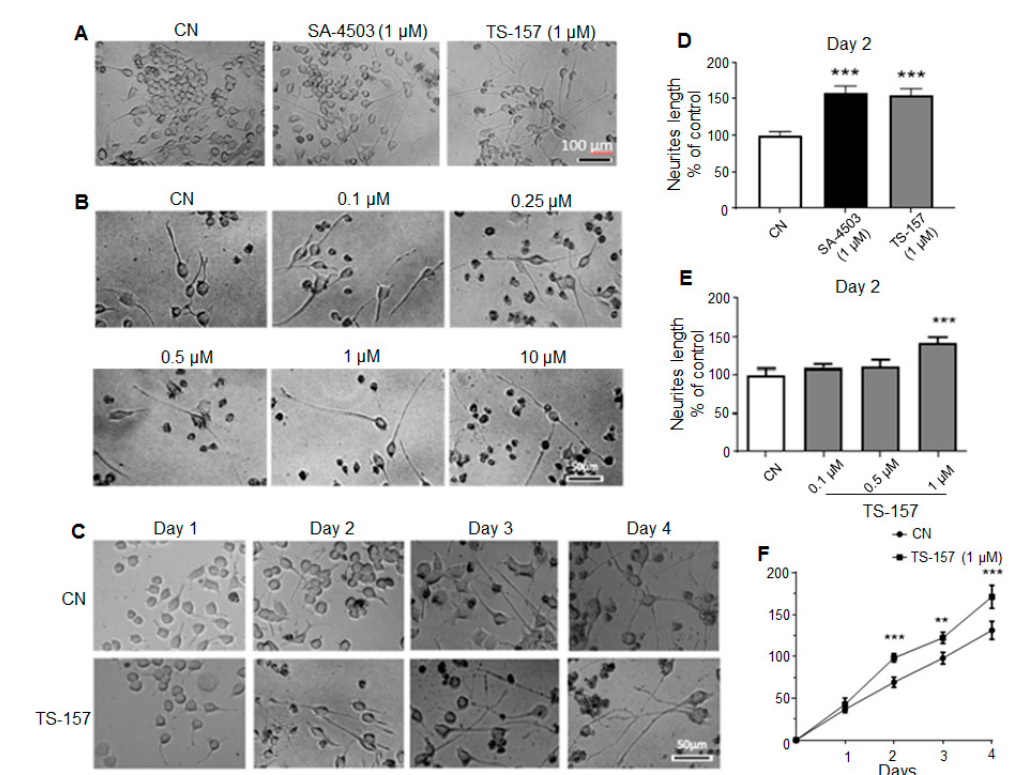
Figure 3. TS-157 concentration- and time-dependently induces neurite outgrowth of N1E-115 neuronal cells. ( A ) Neurite outgrowth induced by SA-4503 and TS-157 at 1 μ M; ( B ) neurite outgrowth induced by TS-157 at concentration of 0.1 μ M, 0.25 μ M, 0.5 μ M, 1 μ M, and 10 μ M; ( C ) neurite outgrowth induced by 1 μ M TS-157 in the 1–4 days after administration; ( D ) SA-4503 and TS-157 have similar ability to induce neurite outgrowth at 1 μ M; ( E ) TS-157 concentration-dependently induces neurite outgrowth of N1E-115 neuronal cells; ( F ) TS-157 time-dependently induces neurite outgrowth of N1E-115 cells. Data obtained are expressed as mean ± SEM, n = 12. Statistically significant differences: ** p < 0.01, *** p < 0.001 vs. vehicle (one-way or two-way ANOVA followed by Bonferroni test).